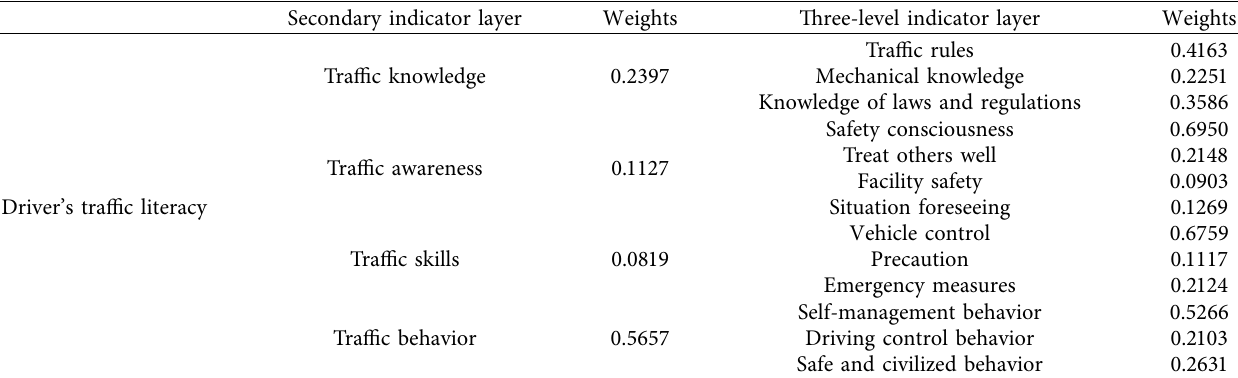
Table 7: Driver’s traffic literacy system indicators comprehensive weighted weight